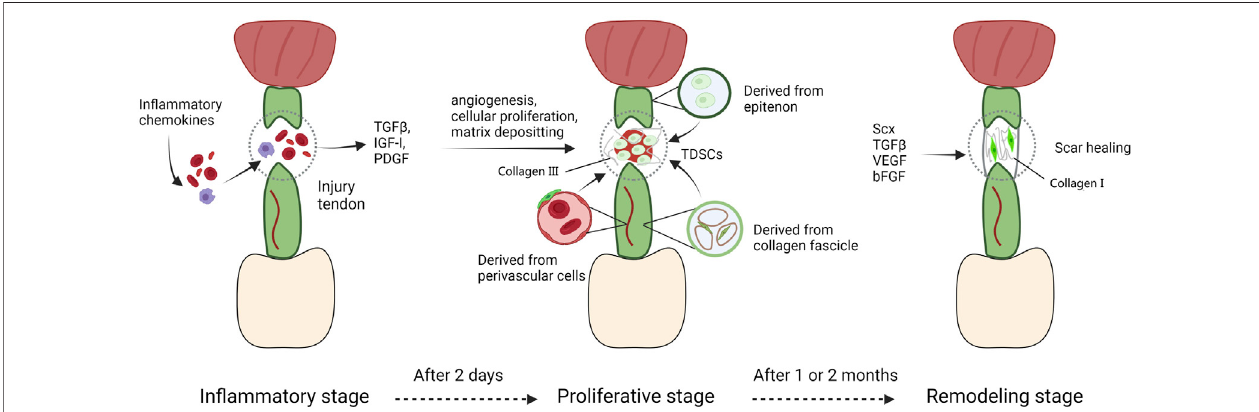
FIGURE 4 | The tendon repair process. The response to adult tendon injury is composed of three blurred-de fi ned stages. The fi rst stage, de fi ned as in fl ammatory stage, spans a couple of days typically. The injured area is in fi ltrated with erythrocyte, leukocytes, and platelets secreting key growth factors and endothelial chemoattractants. During the next stage, macrophages synthesize and release growth factors, and induce cells to recruit towards injury region, and change their role fromphagocytosistoreparationwithacoupleofdays.Inthemeantime,tenocytessecreteaseriousofmatrixesconsistmainlyofcollagenIII.Atthistime,bFGFand VEGF expressed from recruited cells like tenocytes, fi broblasts and in fl ammatory cells reaches apeak, thus promotingcellular proliferation and angiogenesis. In the fi nal stage, main activity that happens is a process of remodeling. A great amount of collagen I begins to be synthesized, and the ECMs deposited among the injured area become more organized. However, the cell density and synthetic activity in repaired region are not able to recover to normal conditions. This stage appears roughly one or two months after the injury and persistent for more than 1